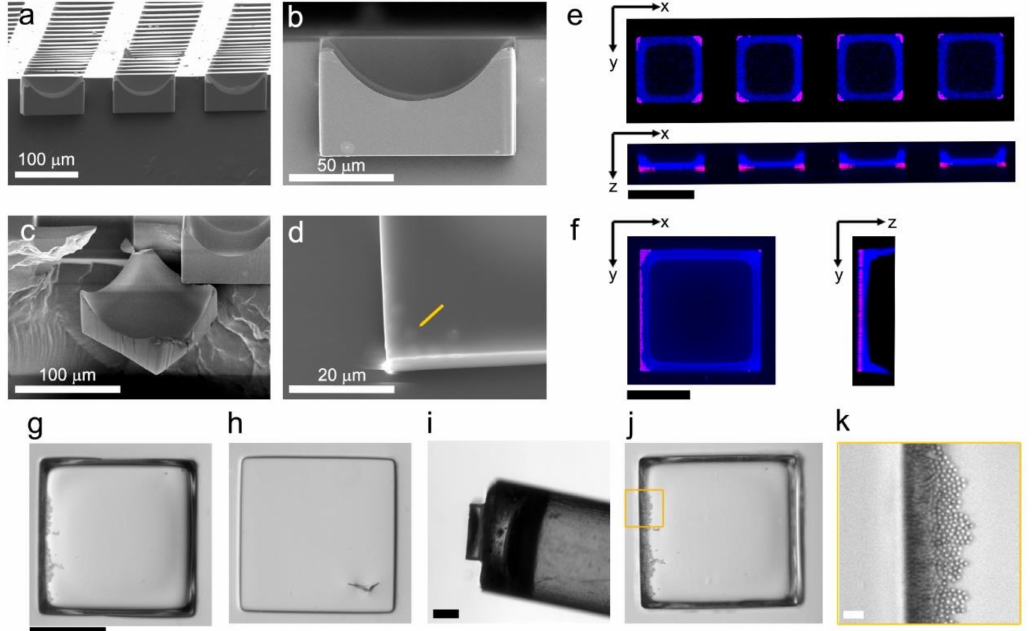
Figure 3. Morphological, structural, and magnetic characterization of fabricated EMAs. ( a – d ) SEM images showing cross-sections of an EMA with magnetic microparticles embedded in polystyrene sitting within 100 µ m × 100 µ m × 60 µ m (width × height × depth) microwells. The magnetic microspheres (see yellow arrow) are faintly visible within SEM images due to charging effects. ( e , f ) Confocal fluorescence microscopy composite images of two sizes of magnetic polystyrene (MPS) embedded microstructure (EM) elements. Microspheres (red) are shown as maximum intensity projections; polystyrene (blue) is shown as median intensity projections. ( e ) Scale bar: 100 µ m. ( f ) Scale bar: 250 µ m. ( g – k ) Brightfield microscopy images illustrating the magnetic manipulation process: ( g ) representative MPSEM element; ( h ) microwell after microneedle ejection of the MPS EM element; ( i ) magnetic wand holding the released MPS EM element; ( j ) MPS EM element after deposition into a liquid filled well plate, with a magnified view ( k , yellow square) showing the embedded magnetic microspheres visible through the transparent polystyrene. Scale bars: ( g – j ): 250 µ m; ( k ): 20 µ m. Microstructures in panels ( a – e ), ( f ), and ( g – k ) were prepared with the swirling method and sifting method,